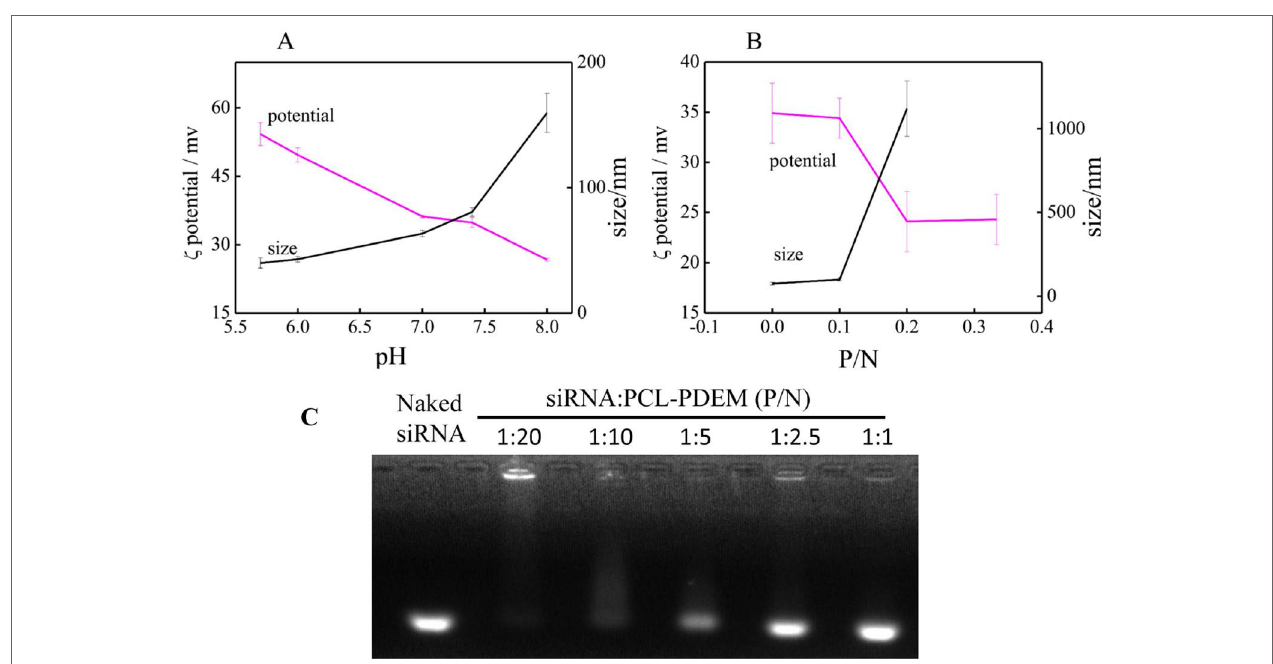
FIGURE 4 | The characterization of nanoparticle. (A) The pH response of PCL-PDEM gene carrier. (B) The zeta potentials and particle sizes of PCL-PDEM/siRNA complexes with different P/N molar ratios. (C) Agarose gel electrophoresis of the PCL-PDEM/siRNA nanoplexes with different P/N